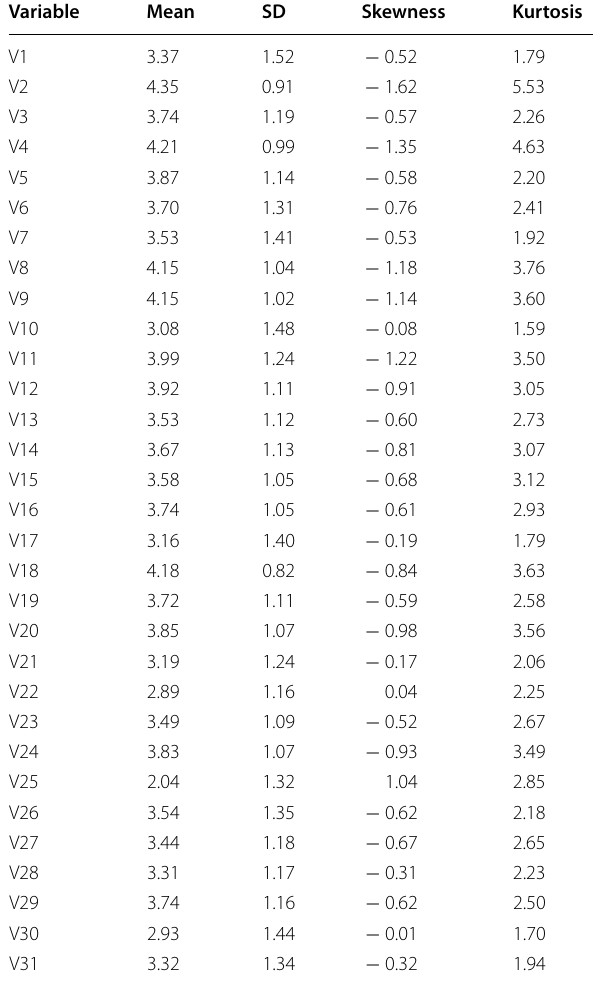
Table 1 Descriptive statistics for the 31 items rated on a 5‑point Likert scale ( n =